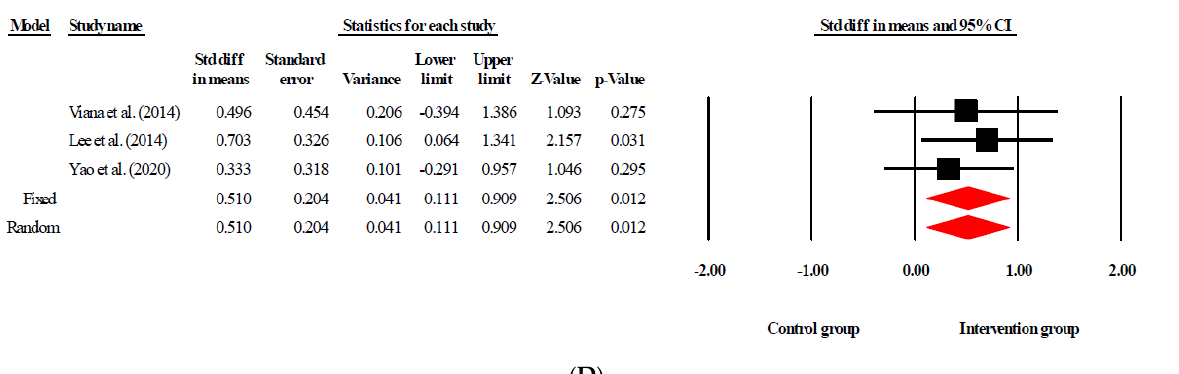
Figure 2. Forest plot showing the effect sizes for transcranial direct current stimulation combined with rehabilitation in stroke patients. ( A ): Constraint ‐ induced movement therapy. ( B ): Occupational therapy/physical therapy. ( C ): Robot therapy. ( D ): Virtual reality therapy. Std diff: standard difference. Funnel plots of effect size against precision were used to investigate the presence of publication bias. The funnel plot was symmetrical across the center of the mean vertical axes of the funnel plot (Figure 3).